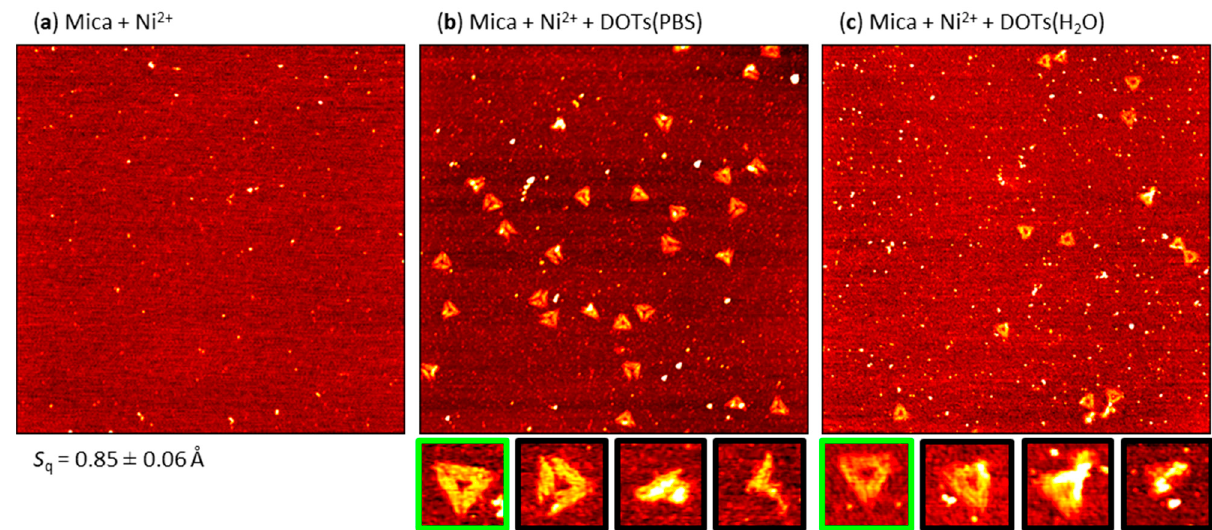
Figure 3. Representative AFM images of ( a ) a mica surface after incubation with NiCl 2 and DOTs adsorbed from ( b ) PBS and ( c ) H 2 O at the Ni 2+ -modified mica surface. The AFM images have a size of 3 × 3 µm² and a height scale of ( a ) 1.5 and ( b , c ) 2.5 nm, respectively. The RMS roughness S q of the Ni 2+ -modified mica surface (average of three AFM images ± standard deviation) is given below the AFM image in ( a ). Below ( b ) and ( c ), example magnifications of intact (green) and damaged (black) DOTs are shown.